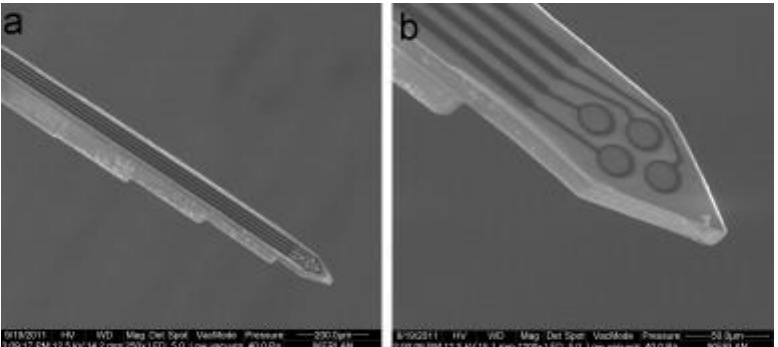
Figure 13. SEM pictures of: ( a ) a layered SU-8 probe and ( b ) the tetrode at probe surface level. Reprinted from Altuna et al. [71] with permission of Elsevier.